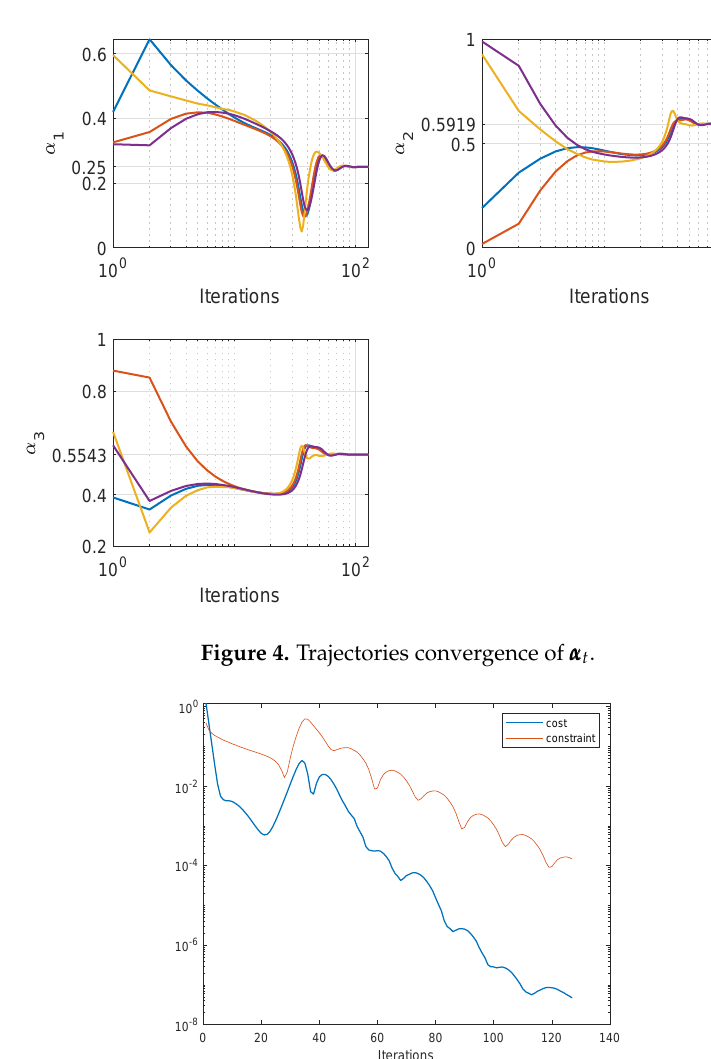
Figure 5. Convergence of the cost function according to its